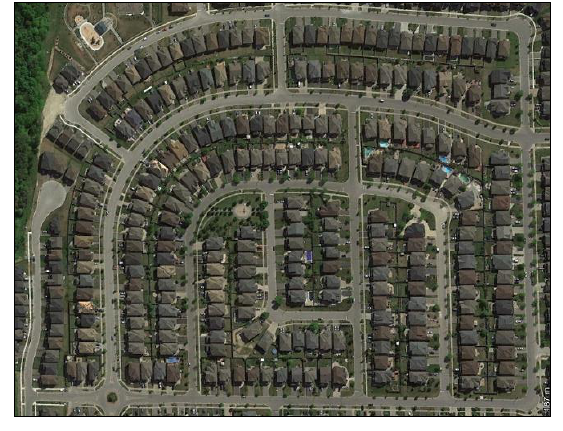
Figure 6. An urban study area The test image has three RGB bands with the approximate spatial resolution of 1m/pixel. In our study, no proper geographical database for road network was available. Therefore the reference road network is digitized manually in ArcGIS 10.3 and is shown in Figure 7.